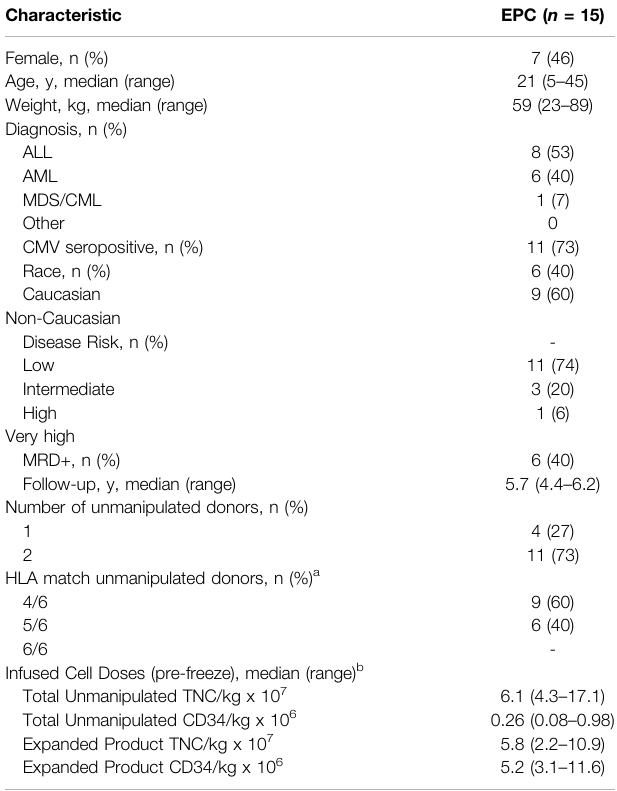
TABLE 1 | Patient and unit characteristics in recipients of ex-vivo expanded cells.